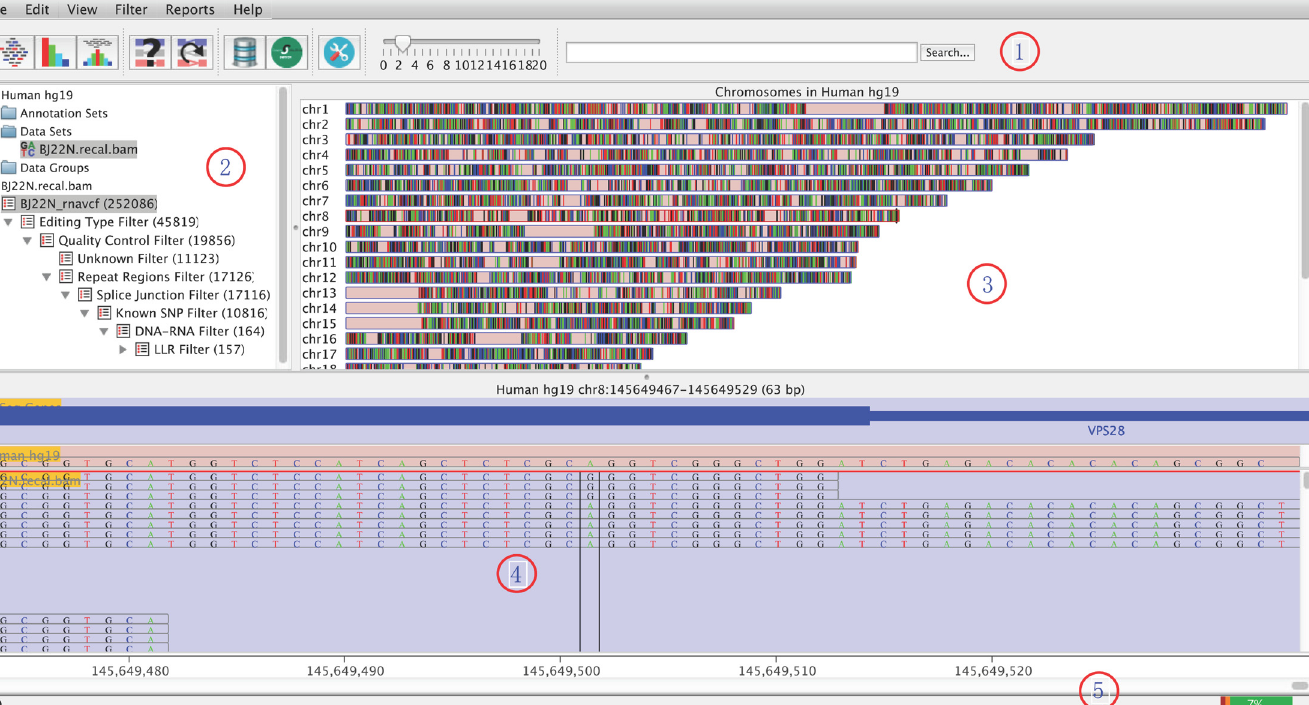
Fig 2. Graphic User Interface of RED. Panel #1, toolbar panel; panel #2, directory panel; panel #3, genome panel; panel #4, chromosome panel; and panel #5, status panel.